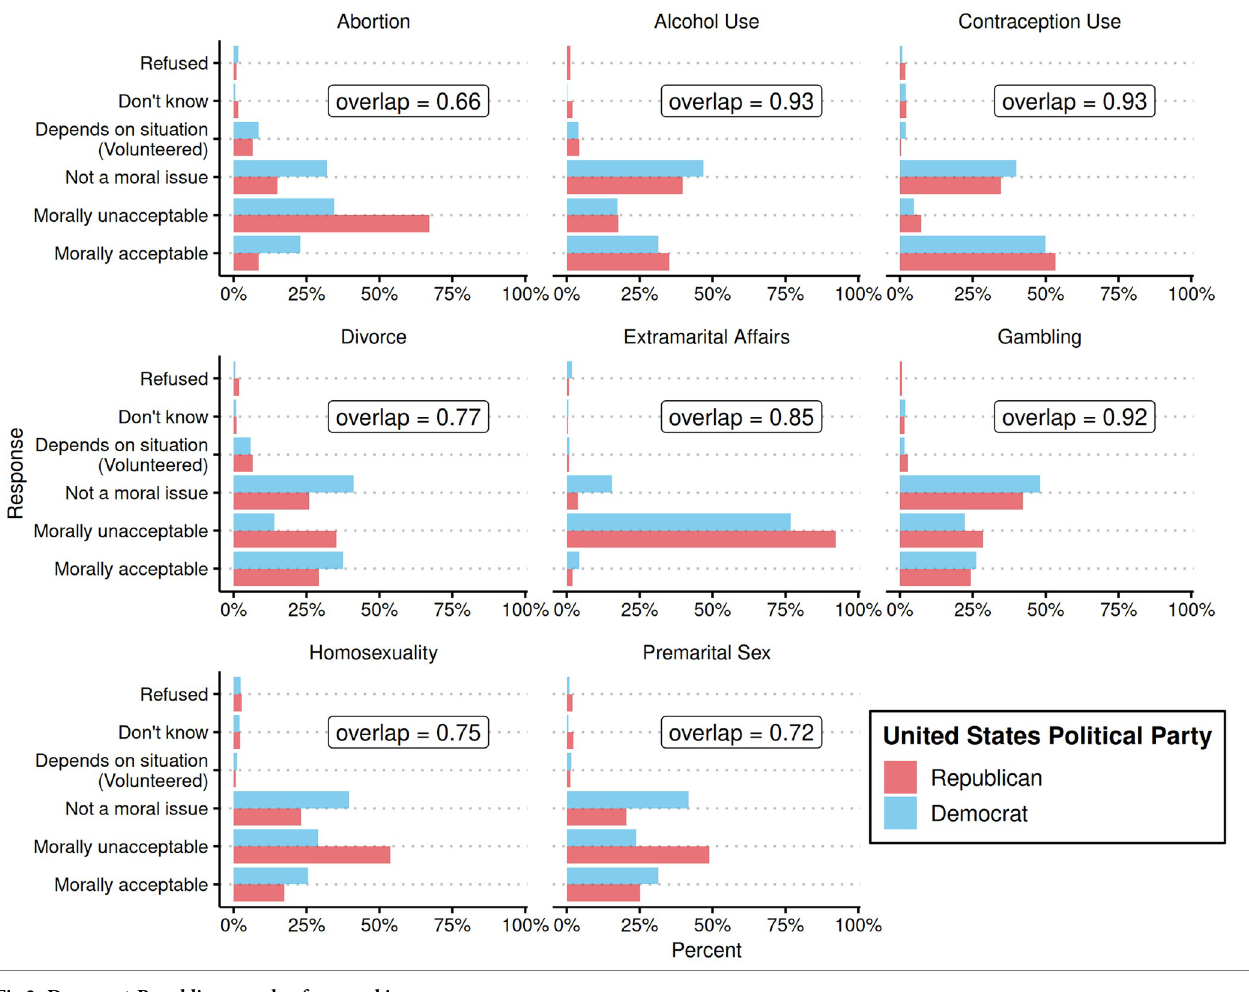
PLOS ONE | https://doi.org/10.1371/journal.pone.0231794 April 23,